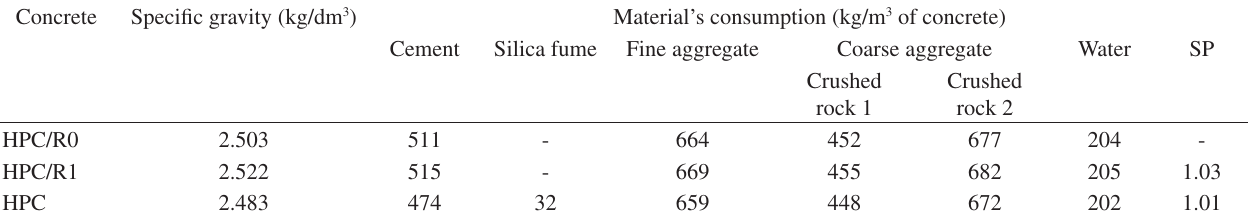
Table 3. Mix proportions and fresh concrete properties. Concrete